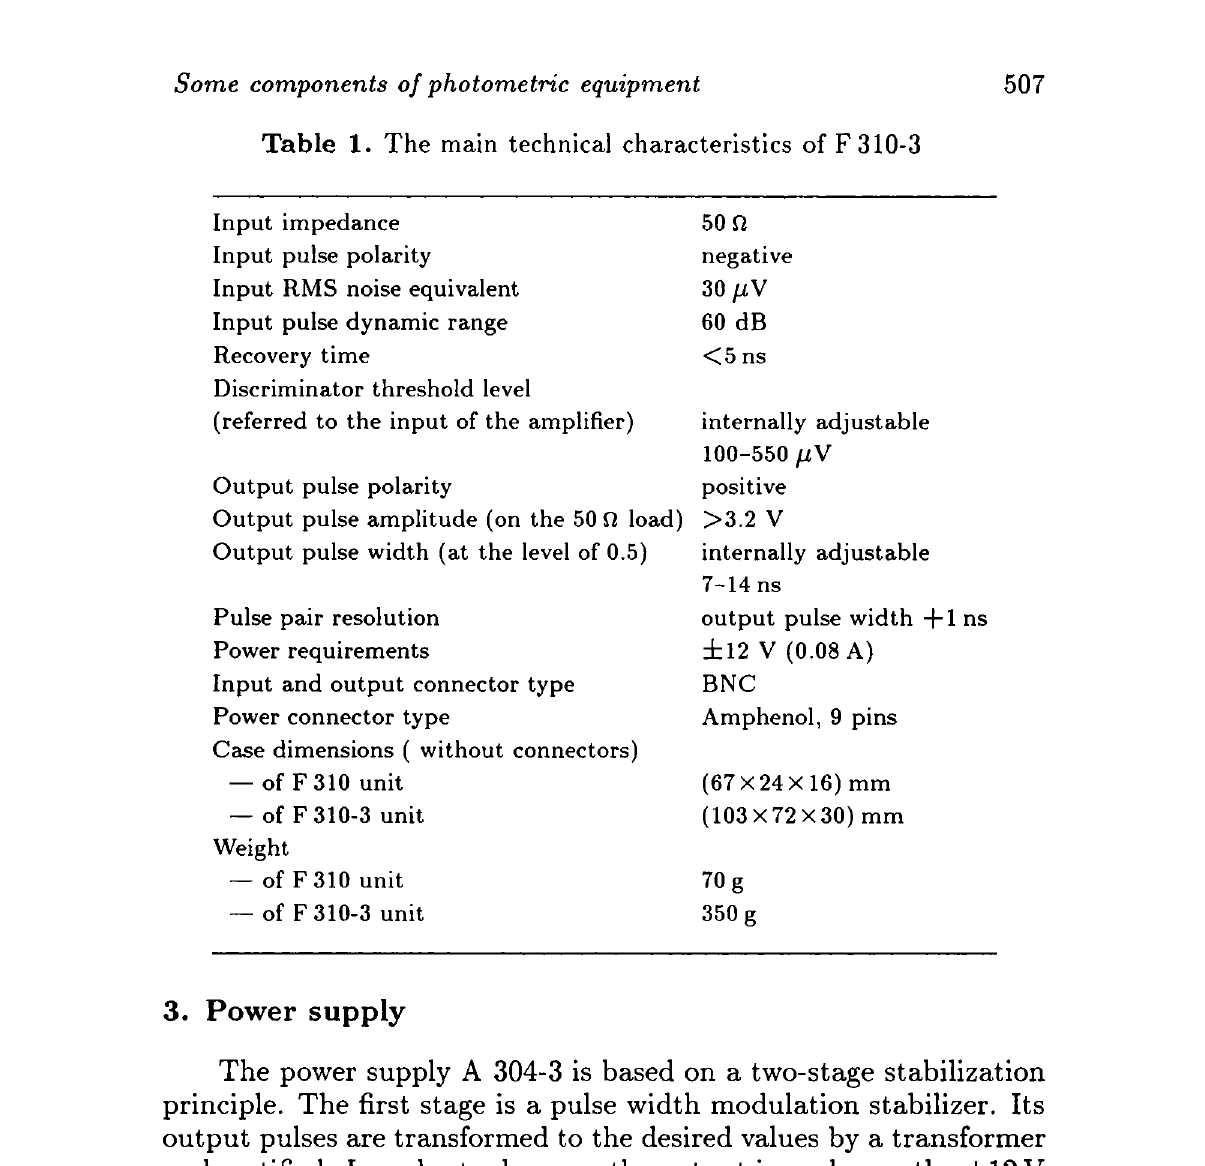
Table 1. The main technical characteristics of F